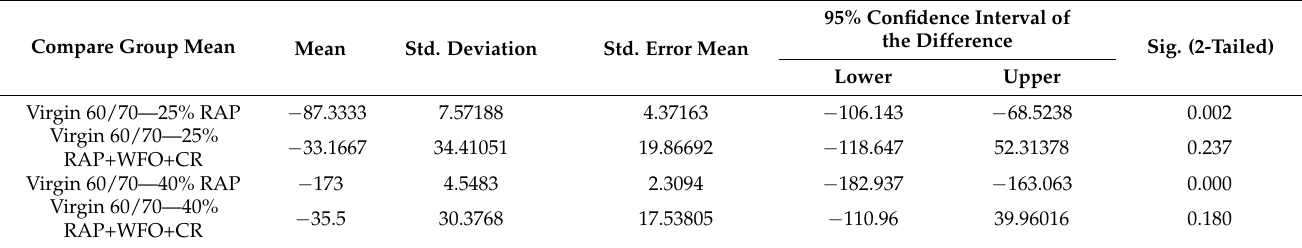
Table 9. Comparison of significant difference of group means for the viscosity result at 165 °C.